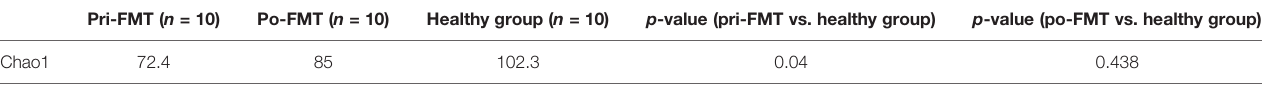
TABLE 1 | Comparison of the Chao1 indexes between healthy donors and patients with non-alcoholic fatty liver disease (NAFLD). Pri-FMT ( n =